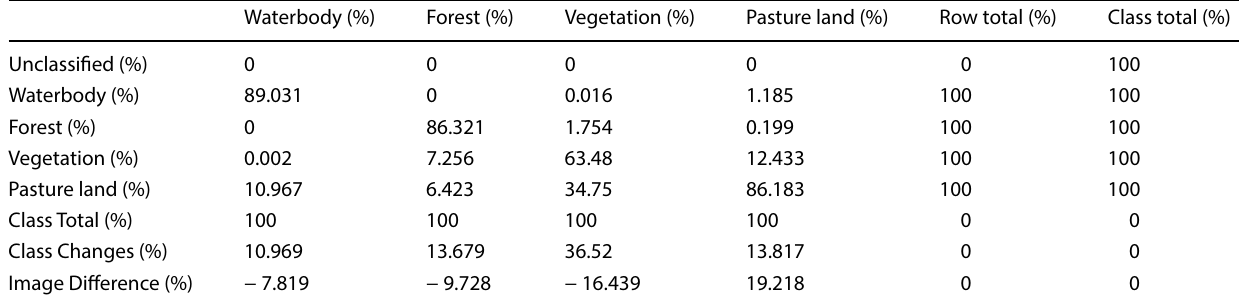
Table 5 Change detection statistics 1991